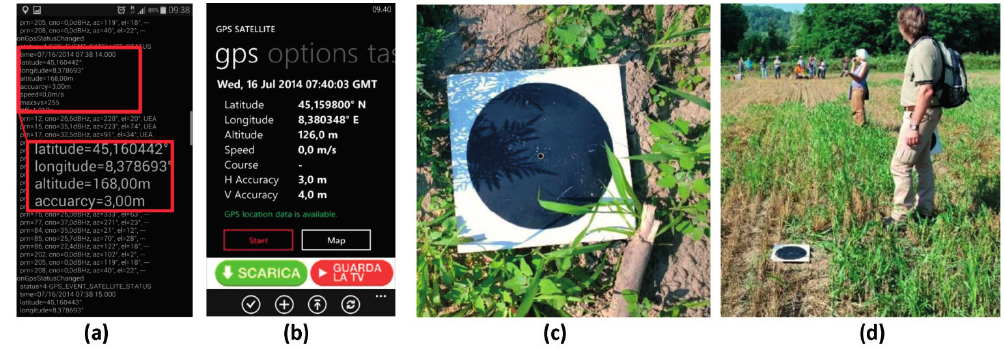
Figure 8. GPS coordinates measured by Samsung S4 with the GPS-GPX logger app ( a ), with the Nokia Lumia app ( b ); Details of the measured markers ( c , d ).